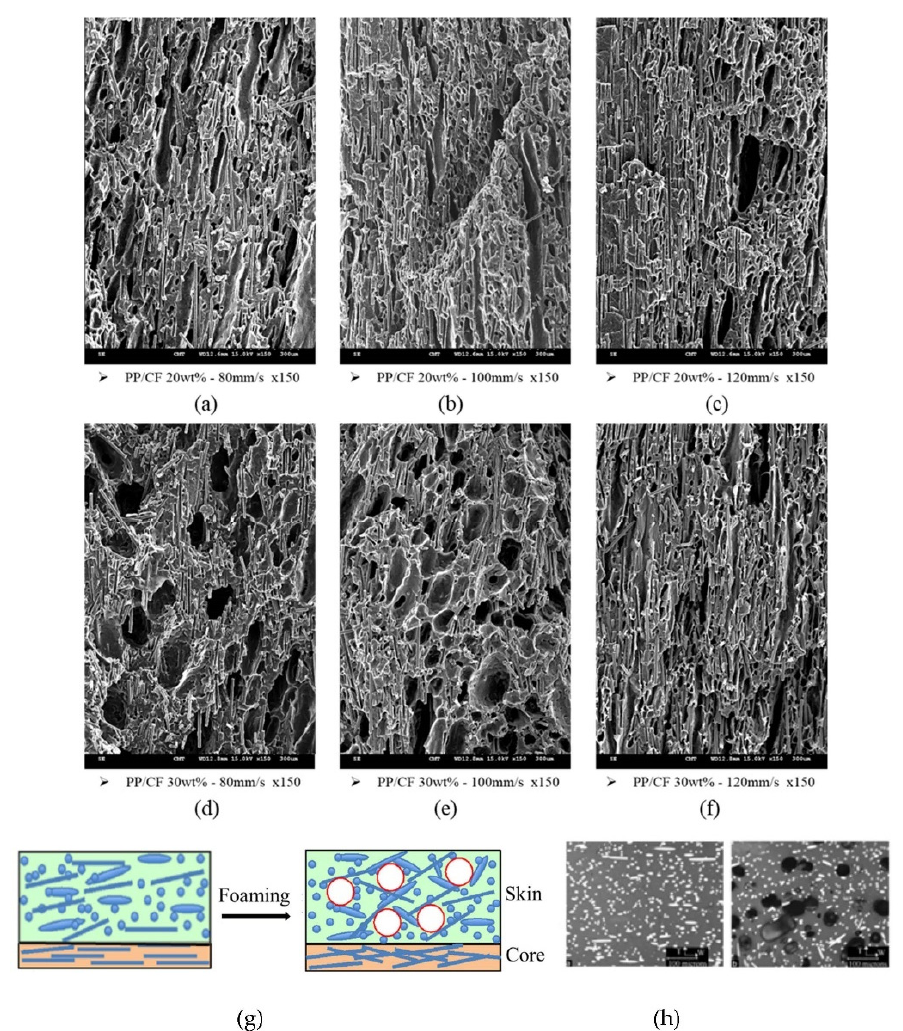
Figure 6. Fiber orientations with SCF-foamed PP/CF composites at various injection speeds. ( a ) PP/CF 20 wt%, 80 mm/s. ( b ) PP/CF 20 wt%, 100 mm/s. ( c ) PP/CF 20 wt%, 120 mm/s. ( d ) PP/CF 30 wt%, 80 mm/s. ( e ) PP/CF 30 wt%, 100 mm/s. ( f ) PP/CF 30 wt%, 120 mm/s. ( g ) Influence of cell foaming on fiber orientation (Schematic). ( h ) Real case.